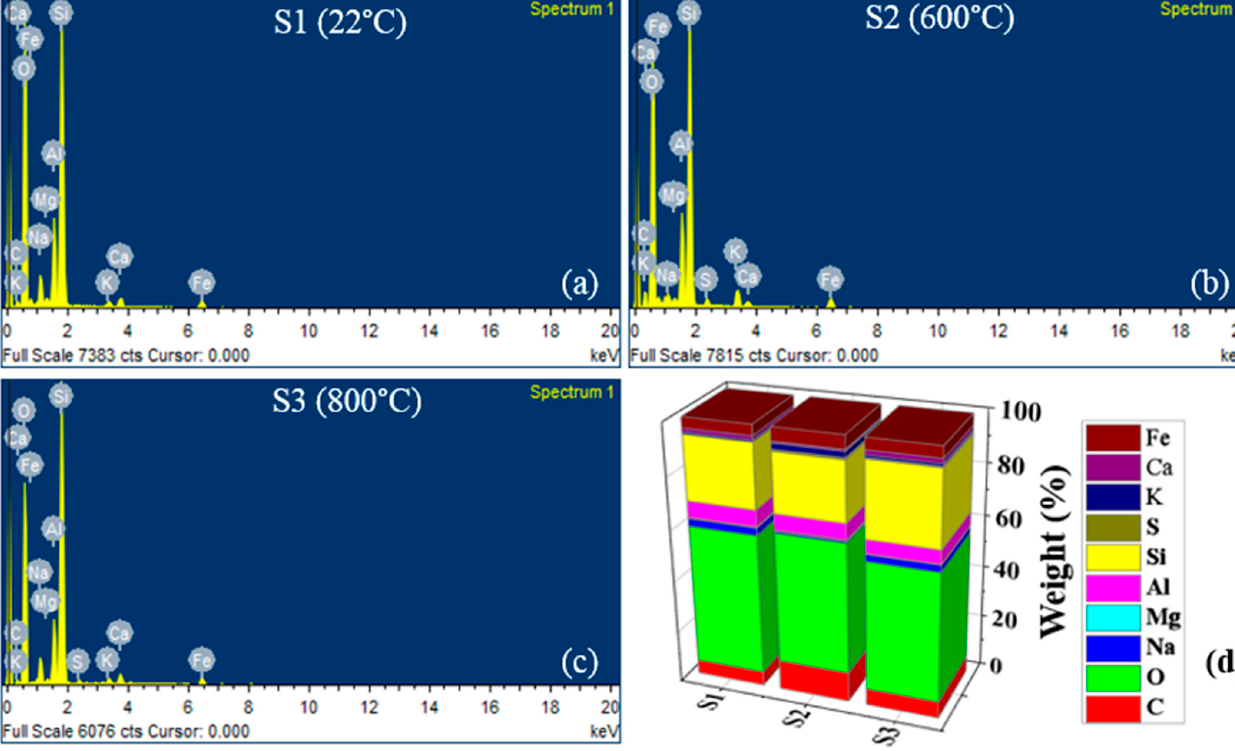
Figure 7. EDX results of representative samples ( a ) S1 (22 °C), ( b ) S2 (400 °C), ( c ) S3 (800 °C), ( d ) weight (%) of elements in the samples S1, S2, and S3.